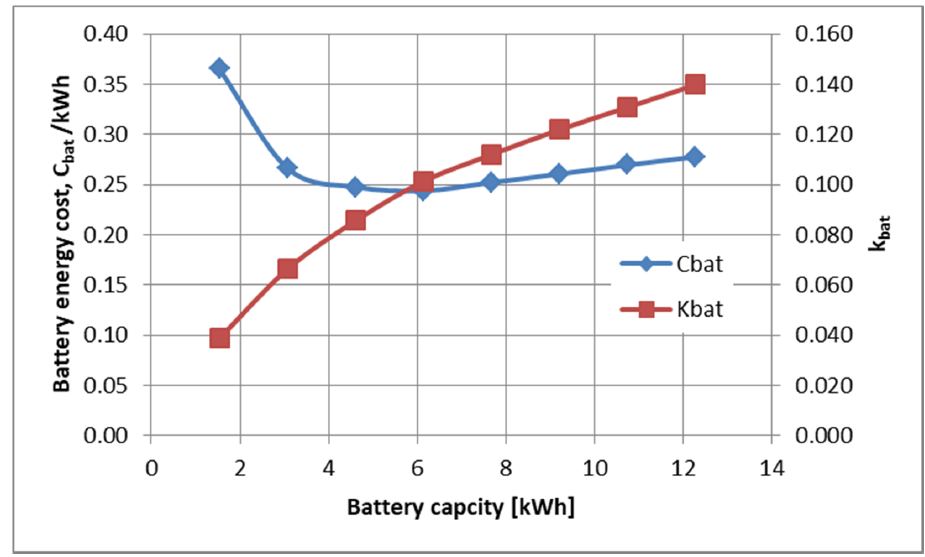
Figure 8. Battery cost analysis.